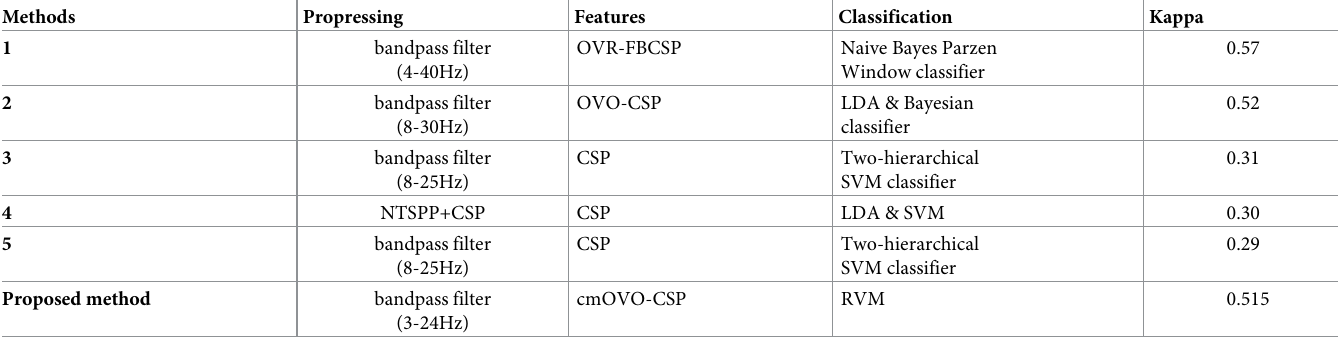
Fig 12 depicts the trained weights computed by three RVM kernel functions. The horizontal axis denotes the index of the RVs corresponding to the learned weight. There are no more than four learned weights in each graph, which produces the sparse classification results. The vertical axis denotes the value of the learned weight. The value of the learned weights in the dif-